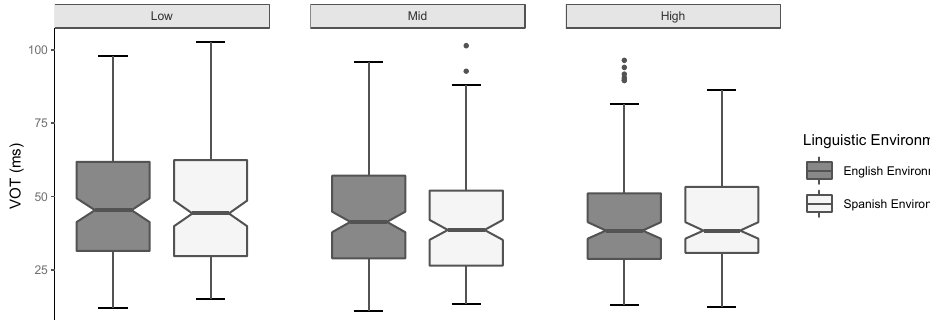
Figure 4. VOT (ms) by linguistic environment and proficiency. For the purposes of illustration only, participants were grouped into low ( n = 6), mid ( n = 7), and high proficiency ( n = 7) groups by the continuous Spanish language component score of the BLP.